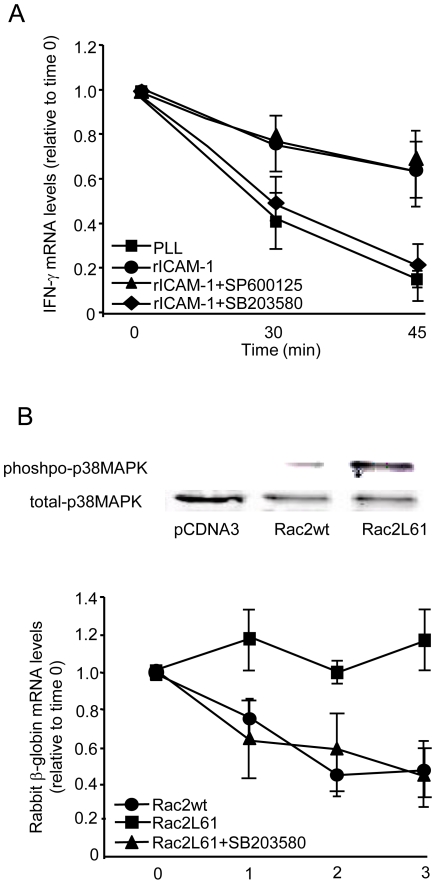
p38MAPK activation requirement in LFA-1- and Rac2- induced mRNA Stabilization.
A, Murine splenic T cells were pretreated with 10 µM SP600125, 1 µM SB203850 or vehicle control, stimulated with PMA 5 ng/ml and plated on PLL - or rICAM-1- coated dishes. Cells were transcription-arrested with DRB 0.2 mM (time 0) and RNA was harvested at 30 and 45 minutes. IFN-γ mRNA decay was determined by qRT-PCR and expressed as fold induction relative to time 0, normalized to GAPDH mRNA levels. B, In addition to the labile chimeric β-globin/uPAR 3′ ARE reporter and CAT constructs, J.Vav1 cells were transfected with pCDNA3, Rac2wt or Rac2L61 constructs. Prior to serum-driven transcriptional activation, cells were pretreated with µM SB203850 or vehicle control for 1 h. mRNA was harvested at the indicated time points (post-serum induction) and β-globin transcript levels were determined by qRT-PCR, shown relative to time 0 and CAT mRNA-normalized. Also shown is activation-specific phospho-p38 (and total p38) immunoblot in the various transfected samples. Data are presented as the mean ± S.E.M. of three separate experiments.